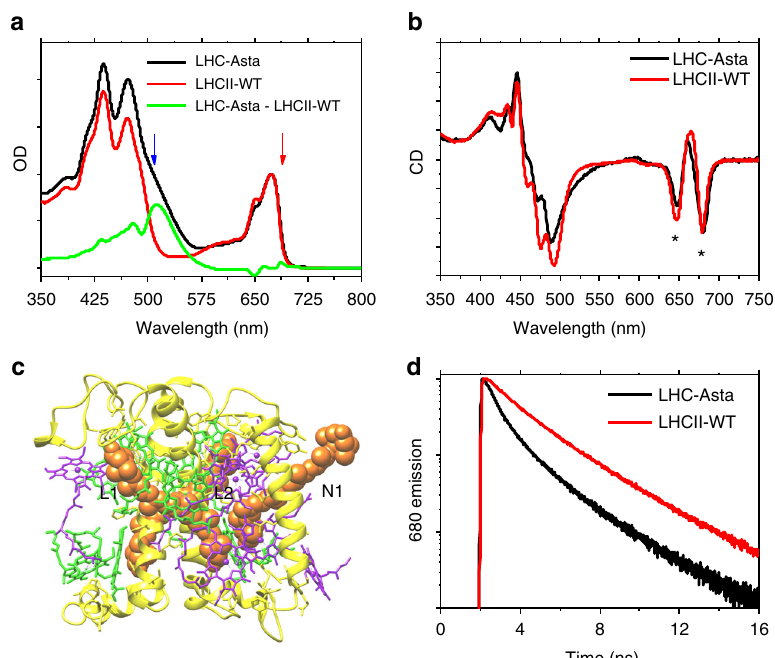
Fig. 1 Spectral characterization of LHC – Asta and comparison with LHCII-WT. a Steady-state absorption spectra (normalized to the Chl content, assumed to be the same in LHC – Asta and LHCII-WT). The difference absorption spectrum (LHC – Asta minus LHCII-WT; green curve) shows features of astaxanthin in solution 35 minus the Cars missing in LHCII-Asta (lutein, neoxanthin, and violaxanthin) 67 . The blue and the red arrows indicates the two excitation wavelengths used for the transient absorption experiments (respectively, 508 and 690 nm). b Circular dichroism (normalized to the OD) of LHC – Asta and LHCII-WT monomers. The asterisks indicate the conserved Chl excitonic bands. c A model of the protein and pigment organization of this complex based on the estimated pigment stoichiometry (about 14 Chls and three Cars per monomer, see text). In the model the protein is depicted in yellow, the Chls a and b in green and purple, respectively, and the astaxanthin molecules in orange. Native Car-binding sites in monomeric LHCs are also indicated (L1, L2, N1). d Fluorescence decay kinetics (normalized to peak value) detected at 680 nm after excitation at 470 nm, y -axis in logarithmic